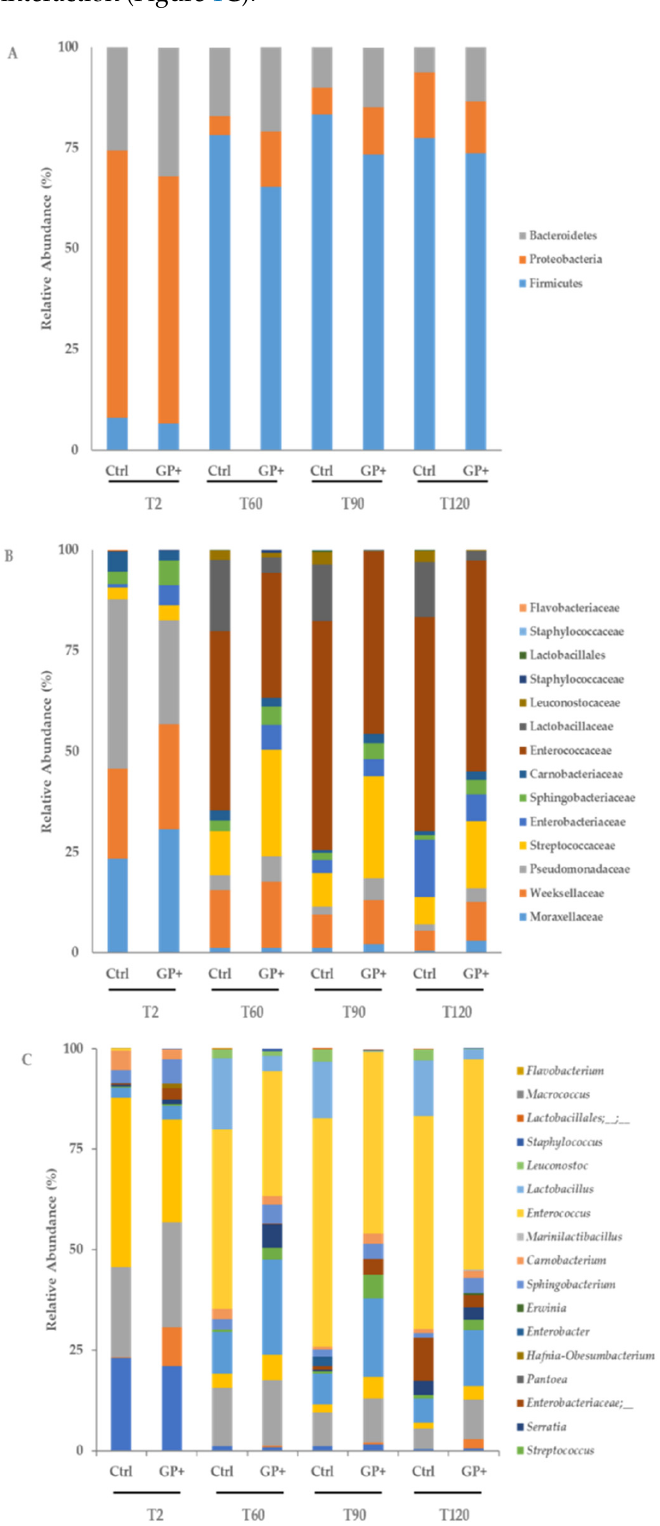
Figure 1. Bar plots of the relative abundance (%) bacterial community composition at phylum ( A ), family ( B ) and genus ( C ) level identified in cheese after 2 (T2), 60 (T60), 90 (T90) and 120 (T120) days of ripening, obtained from raw milk of ewes fed a standard diet (Ctrl) and grape pomace diet